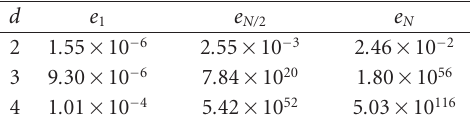
Table 6.7. Approximate error for Example 6.1.